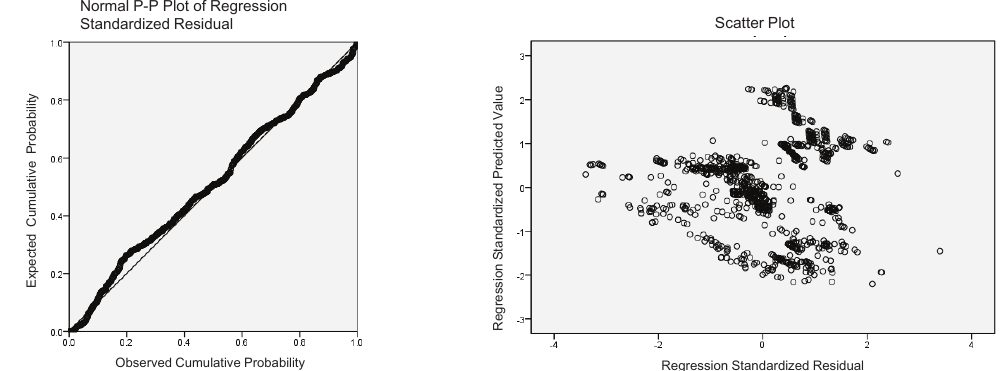
Figure 6. Residual test of model 2: normal probability plot (left) and scatter plot (right)